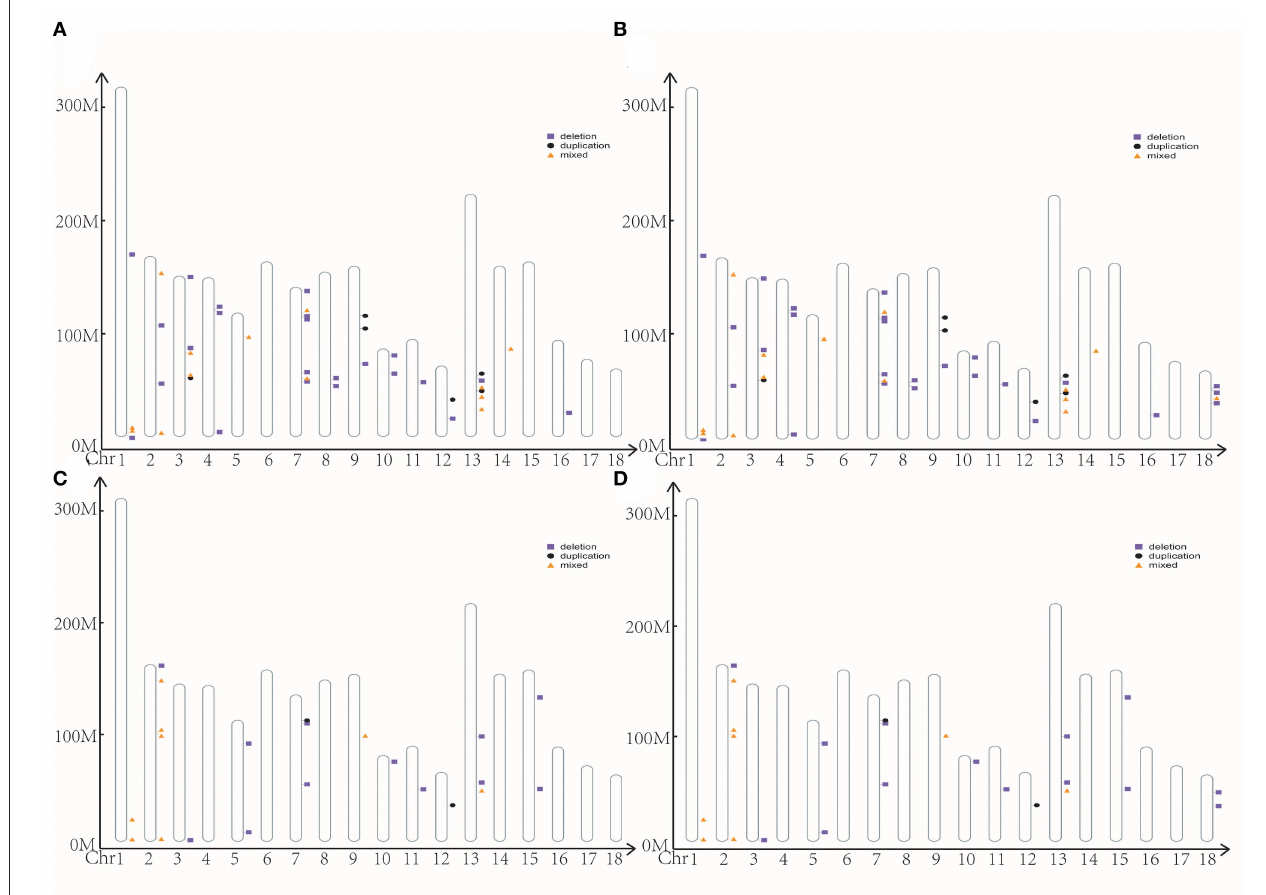
FIGURE 2 | The position of CNVR. (A) CNVR from cnvPartition; (B) CNVR from PennCNV; (C) the common CNVR; (D) the high frequency CNVR.